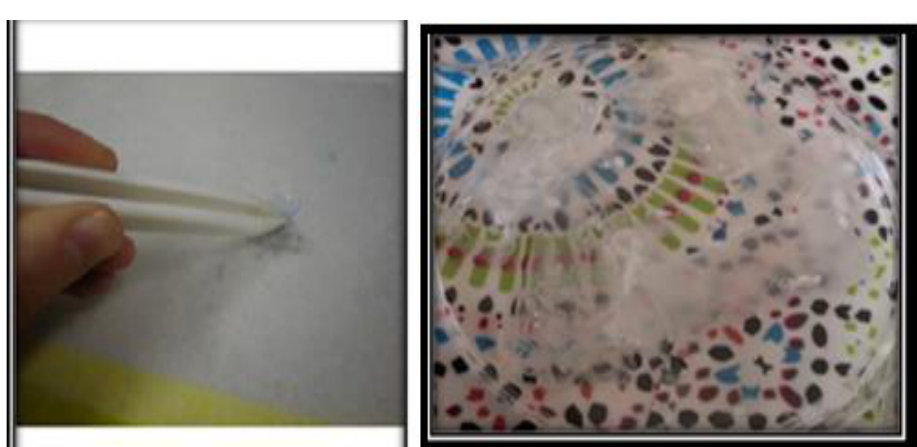
Fig. 3. FTIR spectra for MMA-co-TRIS.